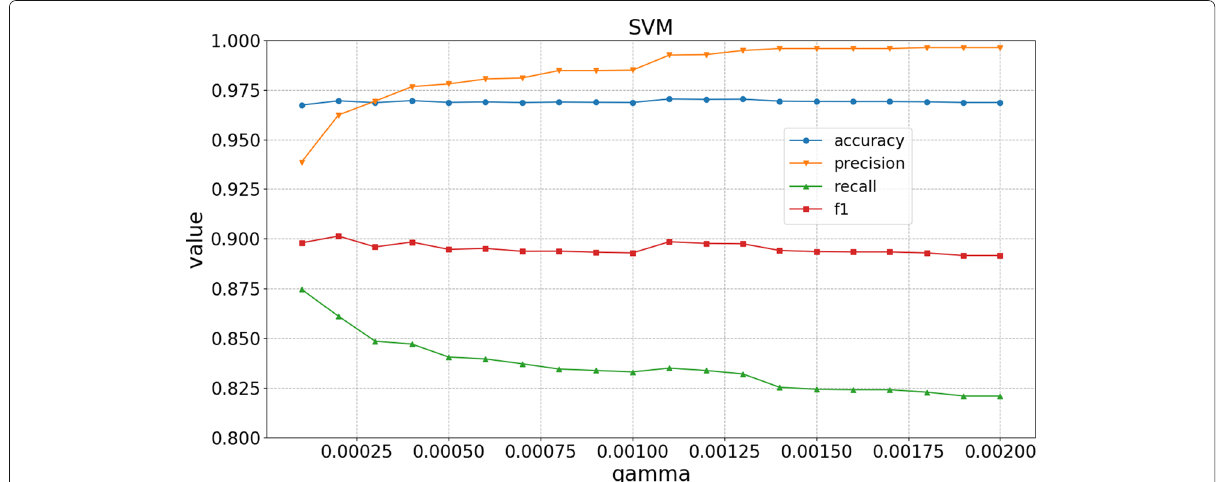
Fig. 3 Result of SVM with regard to gamma. According to the experiment results shown in this figure, the accuracy is around 96%, while the rest of the three metrics are mostly above 80%. With the rising of gamma, the value of accuracy and F1 almost remain constant, while recall falls down a little and precision goes up a little. When gamma is about 0.0002, the four metrics get close to the best performances